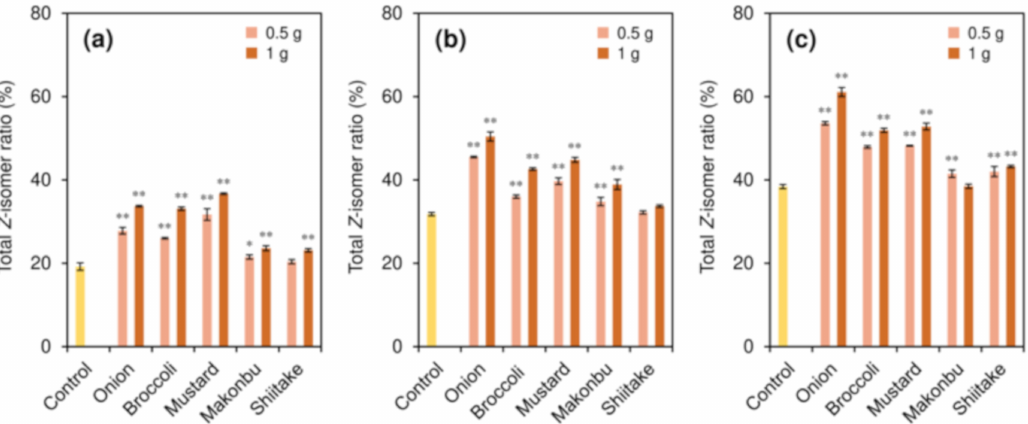
Figure 4. Effects of extraction temperature [( a ) 50, ( b ) 60, and ( c ) 70 ◦ C] and foodstuffs on the total Z -isomer ratio of lycopene in the extract. The foodstuffs (0.5 or 1 g) were added to the extraction process and ethyl acetate was used as an extraction solvent. Error bars represent mean ± standard deviation ( n = 3). Asterisks (*) indicate a statistically significant difference from the control group (* p < 0.05, ** p < 0.01, Dunnett’s t